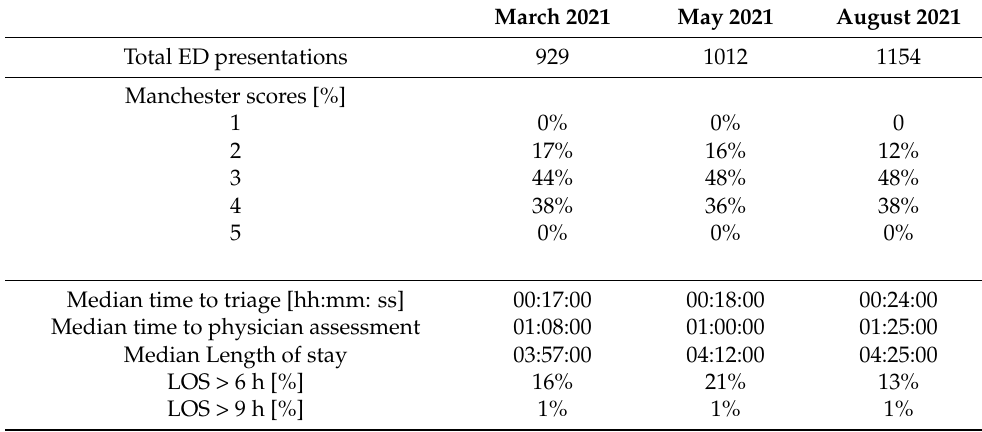
Table 6. Activity, patient acuity, patient flow data for the emergency department control phase–March, May, and August